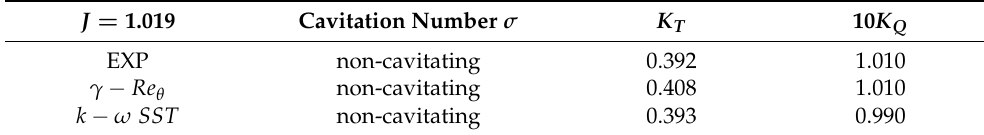
Table 9. Predicted non-cavitating propulsion